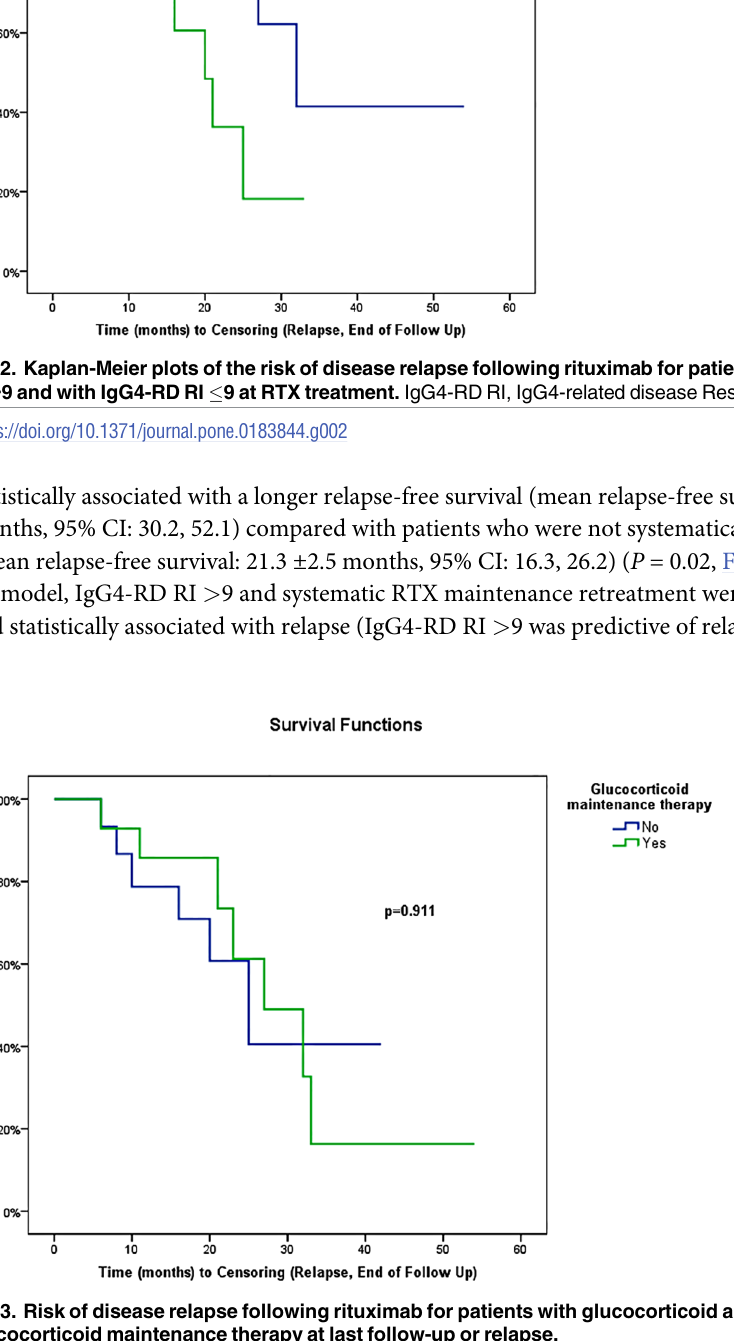
Fig 3. Risk of disease relapse following rituximab for patients with glucocorticoid and without glucocorticoid maintenance therapy at last follow-up or relapse.